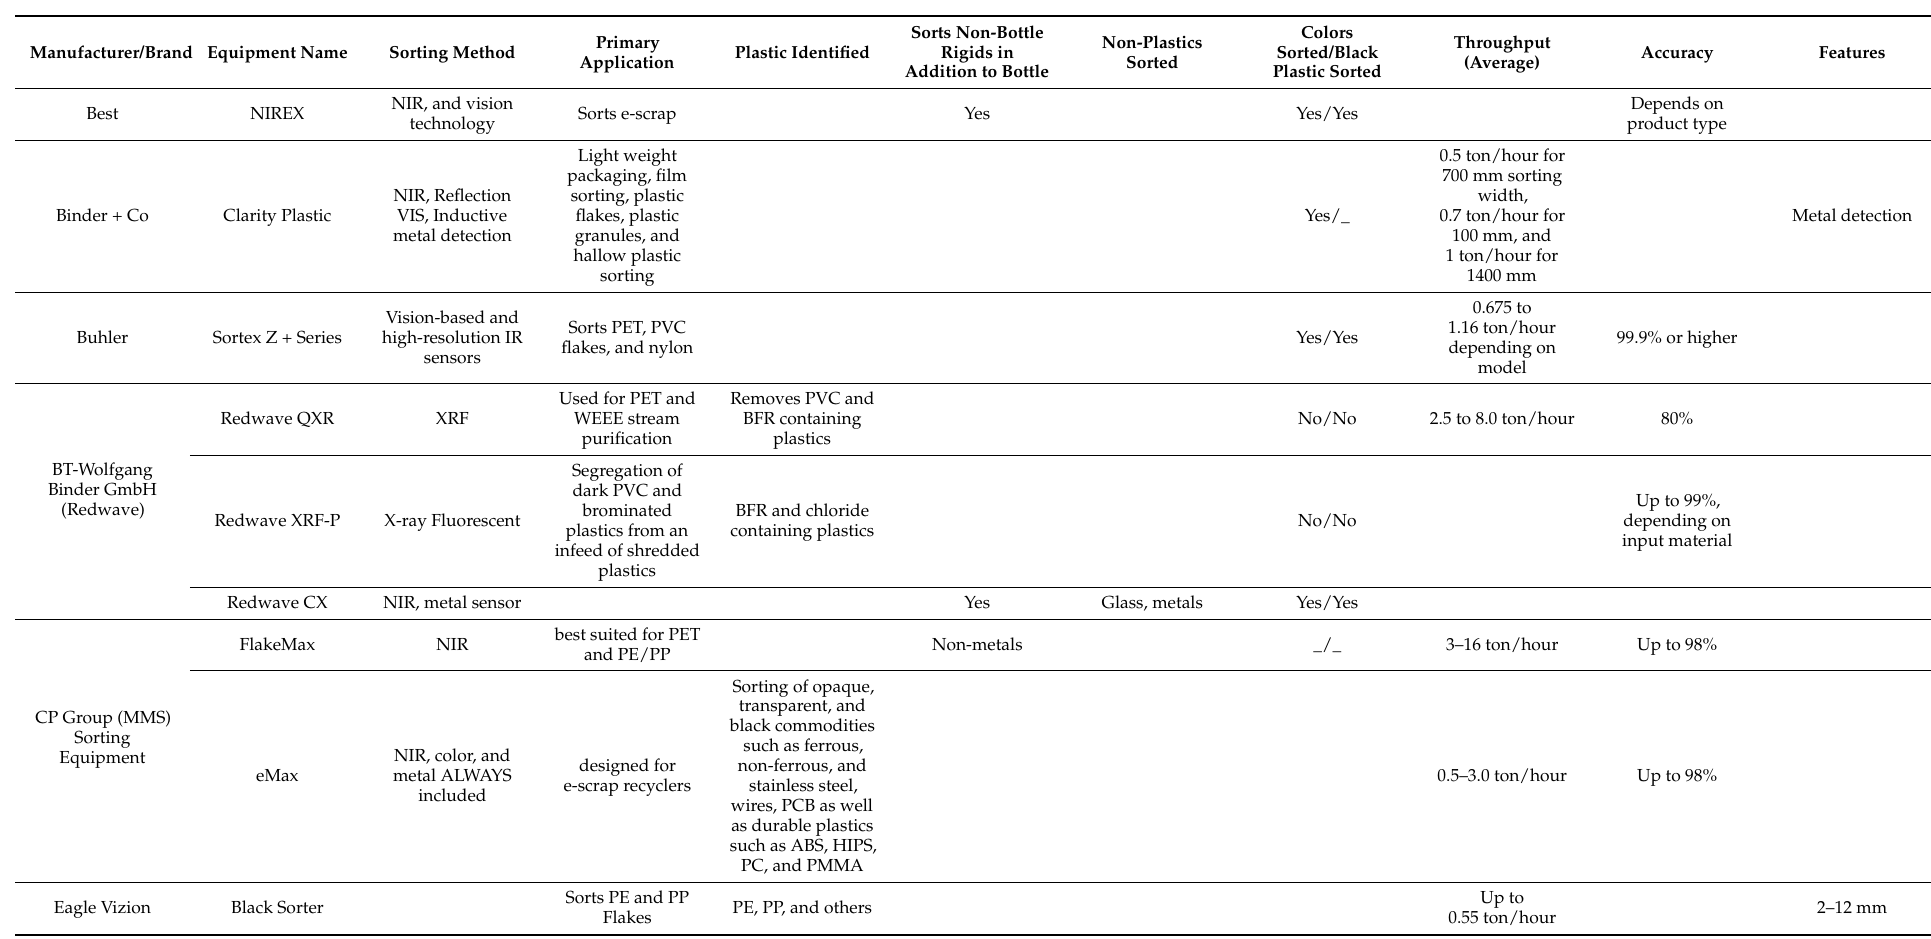
Table 5. Inventory of commercially available flake